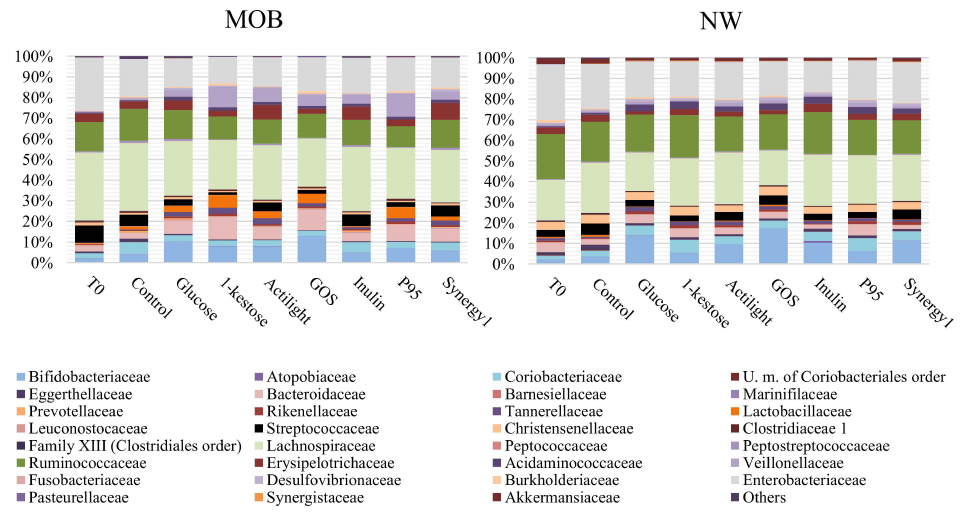
Figure 1. Microbial composition (relative abundance %) evaluated by 16S rRNA gene profiling at family levels in basal conditions (time 0: T0) and after 24 h of incubation in fecal cultures with several carbon sources and without an external carbon source added (Control) in morbid obesity (MOB) and normal-weight (NW)